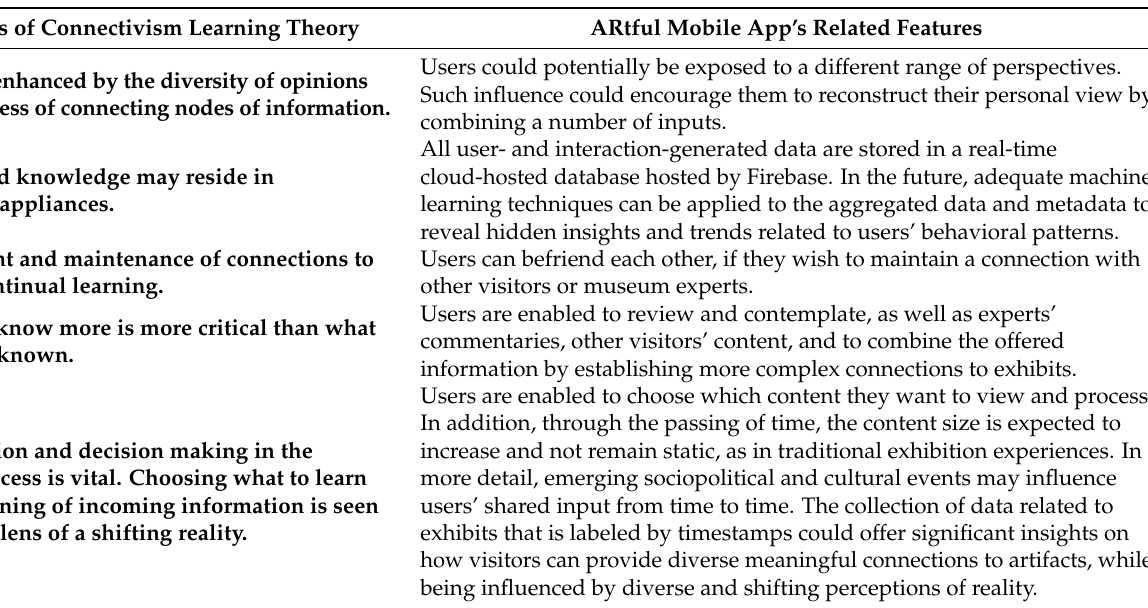
Table 3. Description of how the ARtful mobile app’s design and development was influenced by the key principles of the Connectivism learning